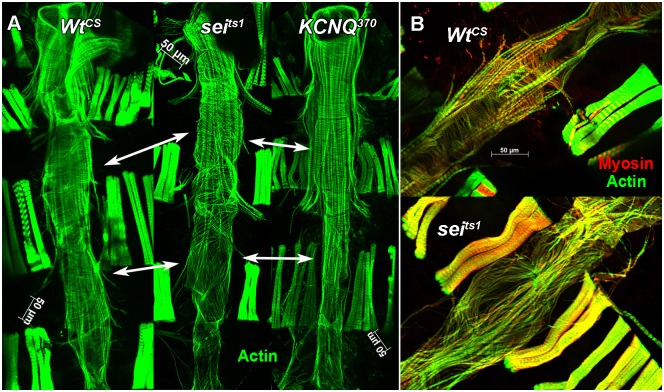
Actin and myosin staining of isolated hearts shows myofibrillar reorganization in seizure mutants.(A) Z stacks from in situ hearts (1 week old) stained with phalloidin to show actin filaments (green). Both WtCS and KCNQ370 mutant hearts show distinct circumferential myofibrils that are tightly packed. Sei mutant hearts show gaps between myofibrils that are disorganized (double headed arrows indicate comparable chambers of the heart). In addition, valve structures appear to be compromised (arrow heads). (B) Higher magnification of one chamber of the heart (abdominal segment 4) stained for actin (green) and myosin (red). Myofibrils in the heart from a 3 week old WtCS fly (top) are circumferentially organized and tightly packed; the same region from a 3 week old seits1 mutant heart (bottom) that shows severe myofibrillar disarray and obvious gaps.